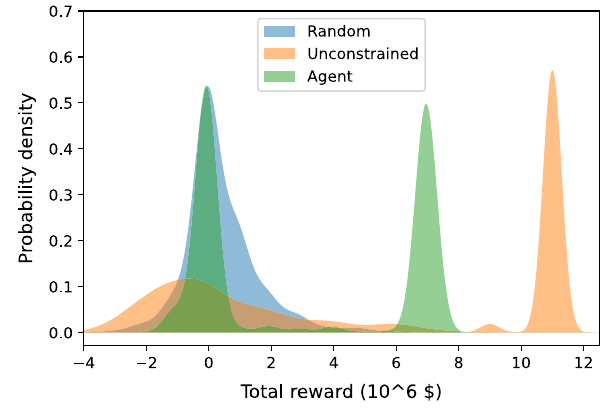
Fig. 4 Total reward after 1000 episodes for a random policy, the unconstrained policy, and the agent which is subjected to the con- straint that action 3 is not allowed unless P ( 𝜃 = 0.99 ) >